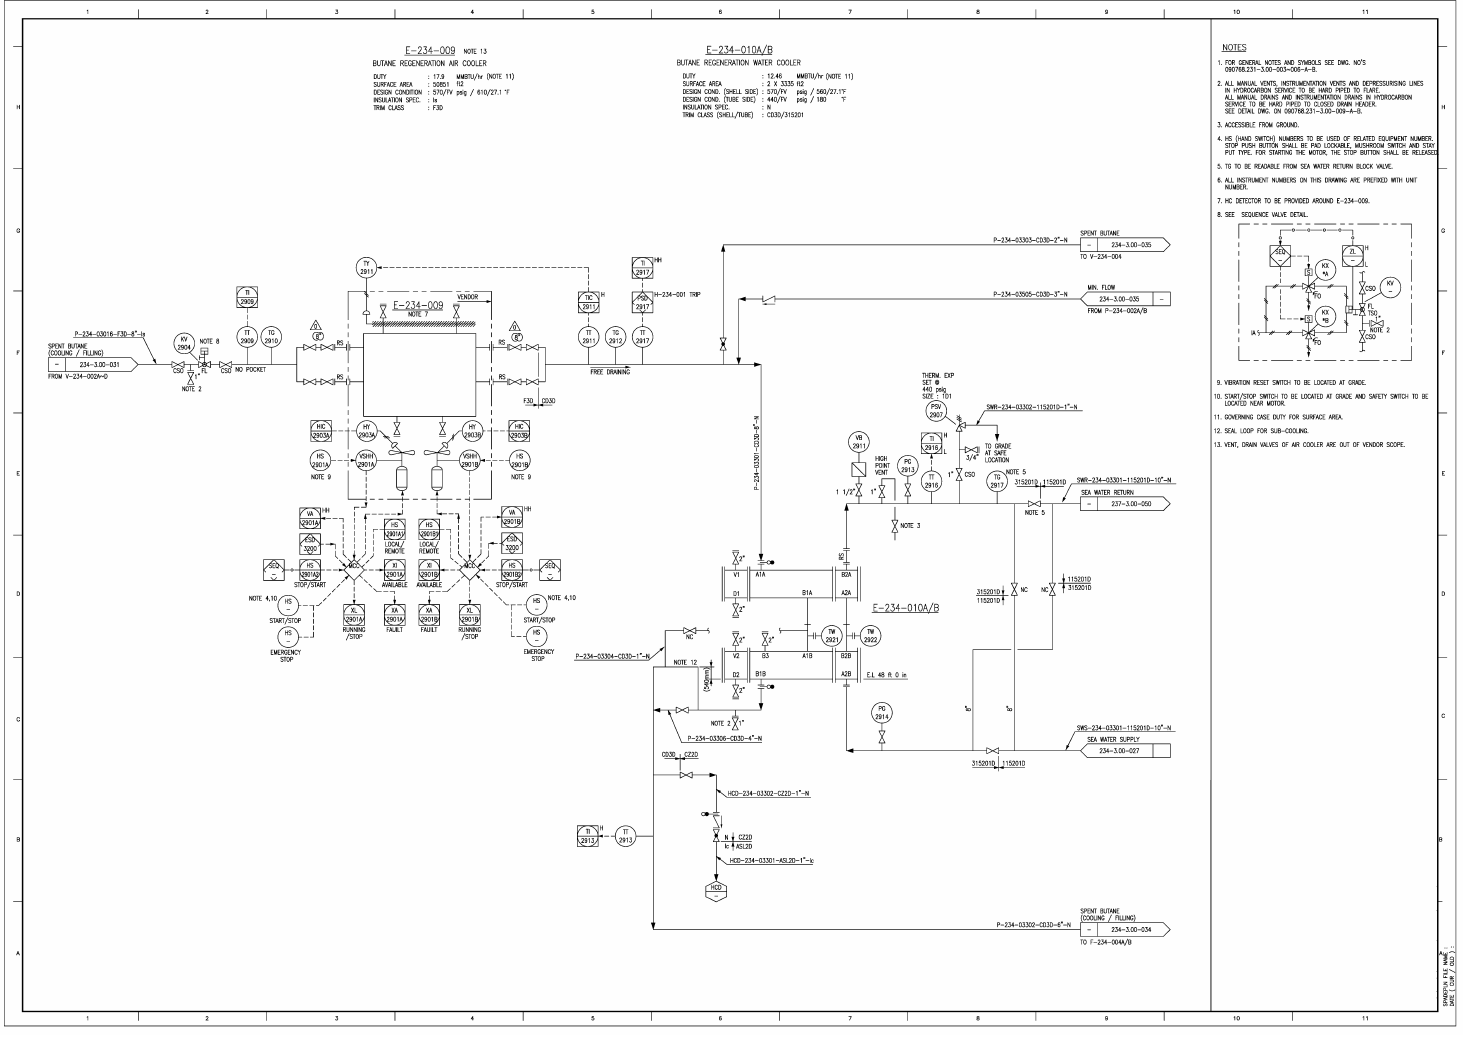
Figure 3. EOs content on hemp inflorescence dry weight. Means with the same letter are not significantly di ff erent. LSD at 5% level. Bars represent standard error. Figure 2. Imaged P&ID drawing